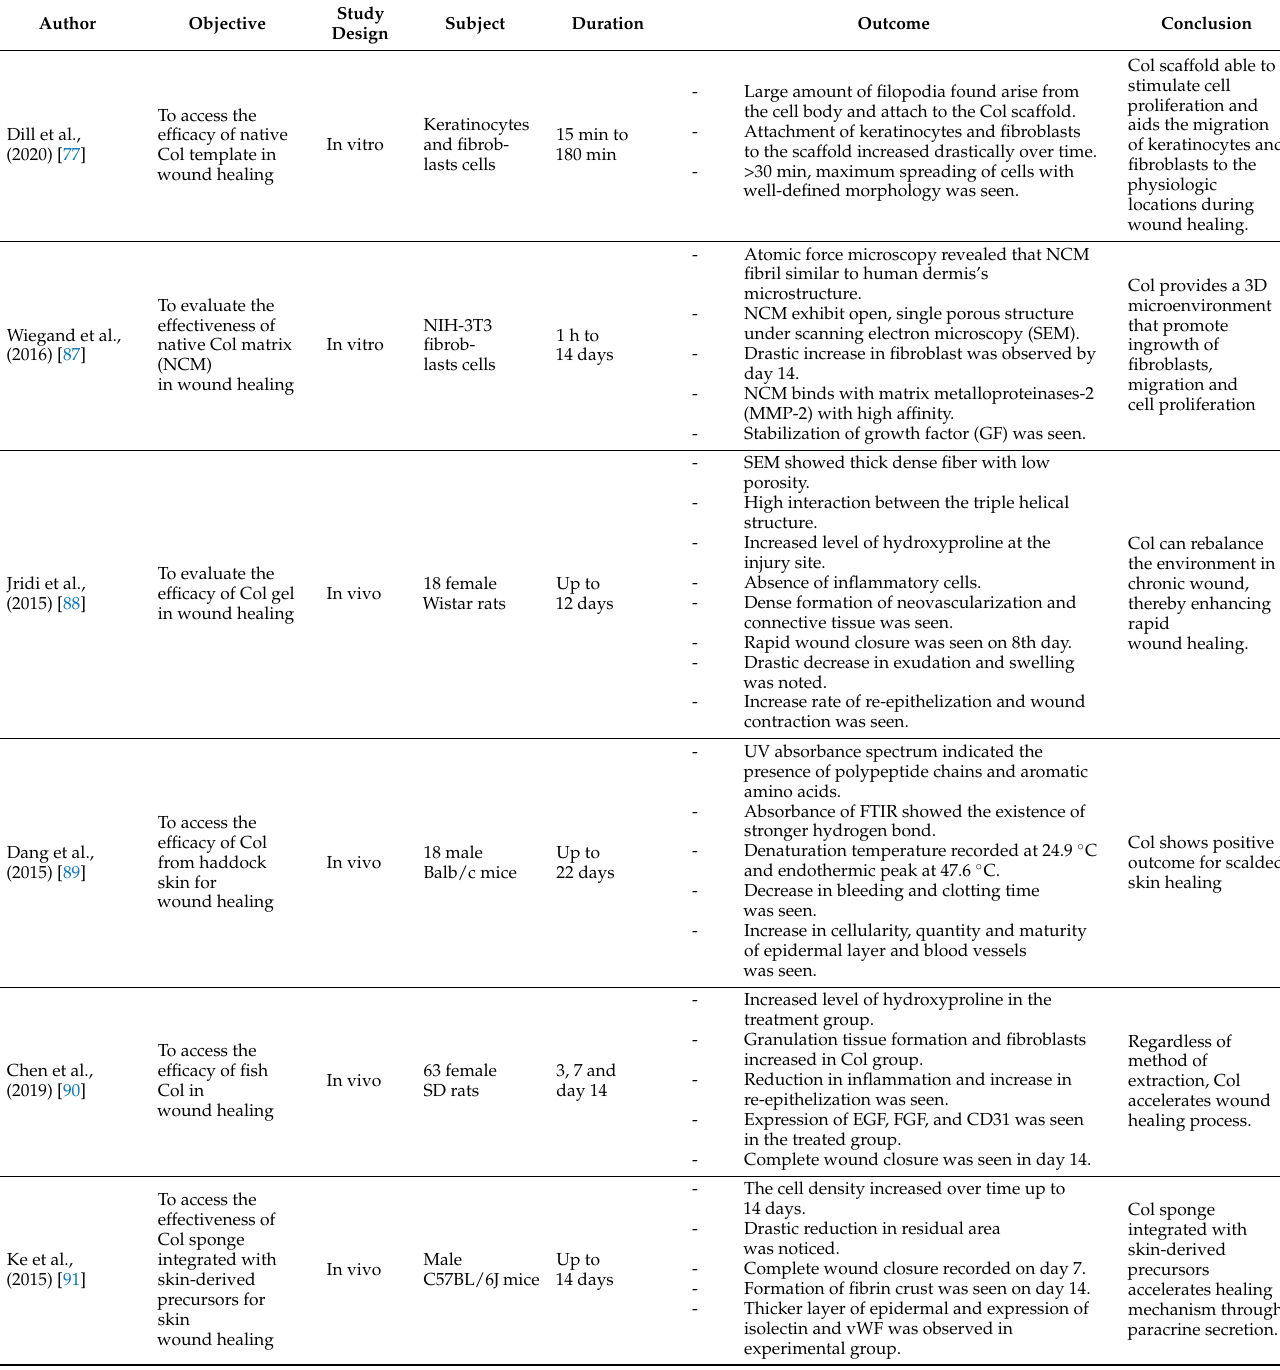
Table 3. In vitro and in vivo studies of native collagen for skin wound